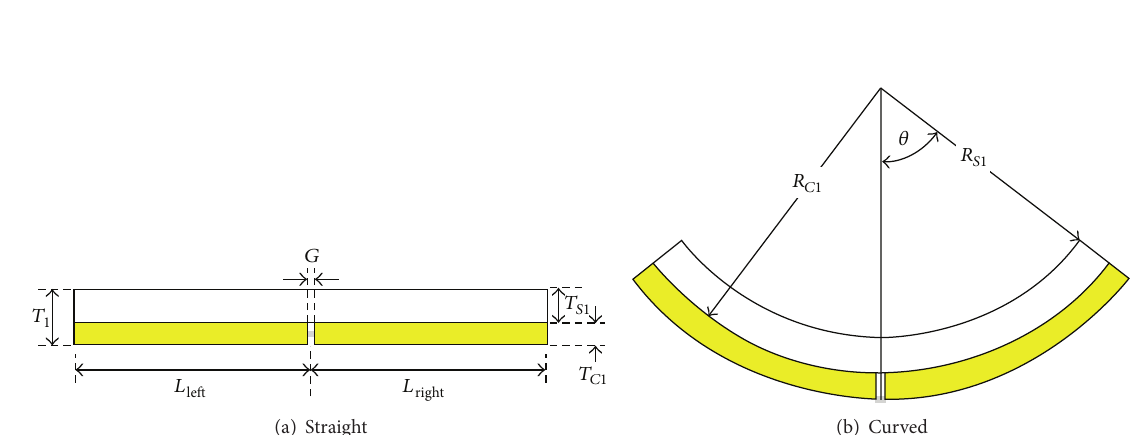
Figure 5: Schematic of double-layers strip dipole.